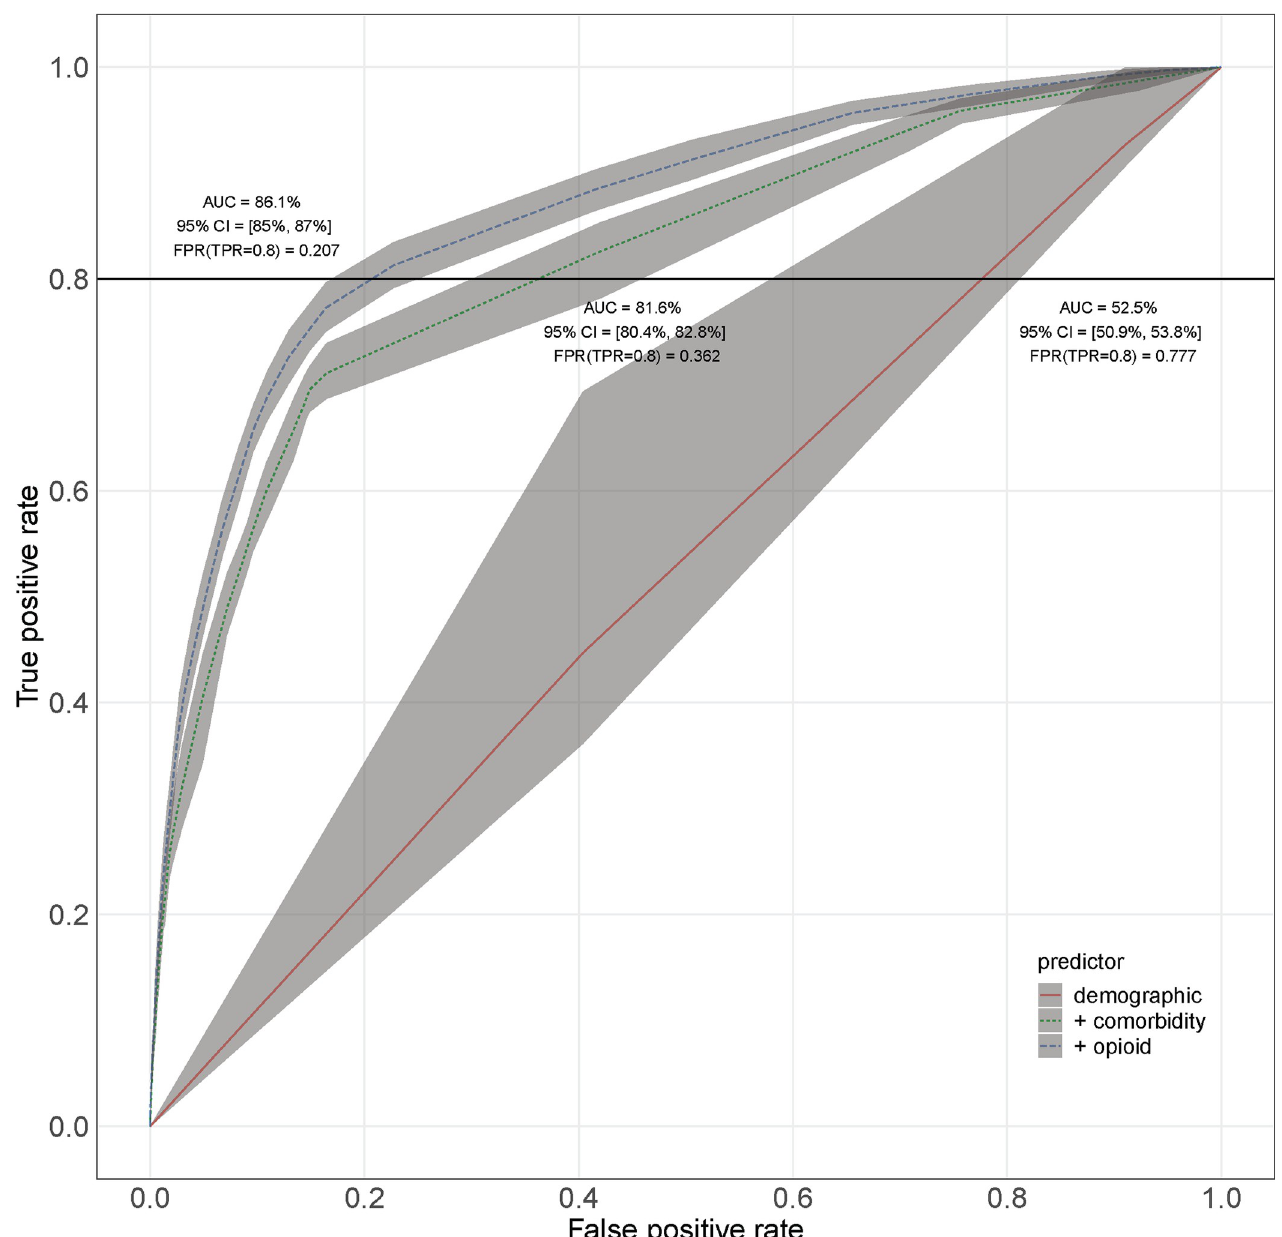
Fig 2. ROC curve showing the performance of one-year suicide attempt prediction using nested Cox regression models. The solid red line is from the model including only demographic variables. The dotted green line is from a model that adds the psychiatric and medical conditions, and the dashed blue line is from the model that adds the opioid use